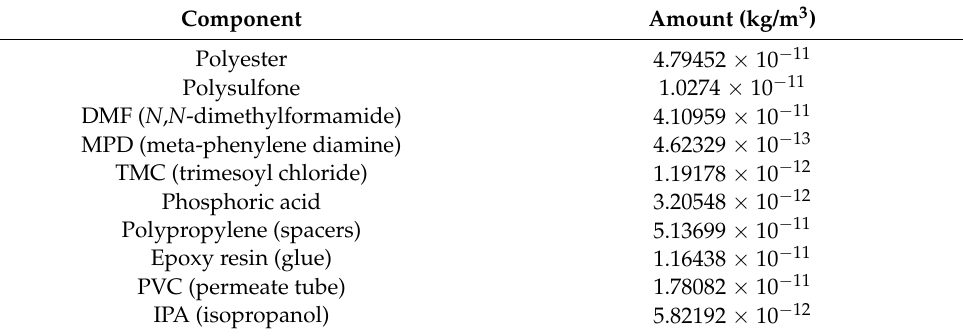
Table 3. Materials usage in fabrication of NF modules for their lifetime.